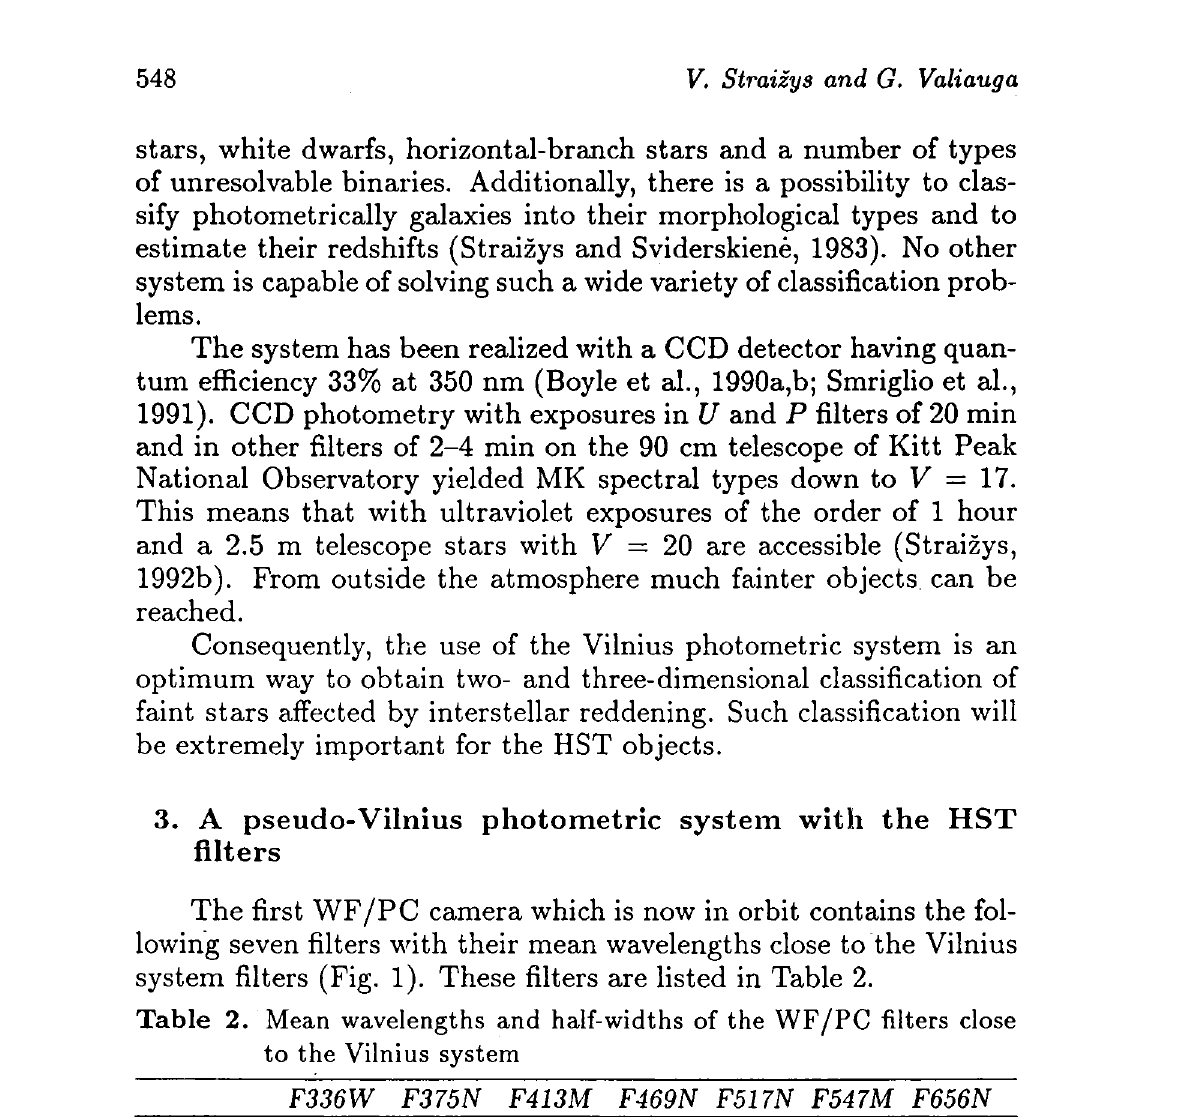
Table 2. Mean wavelengths and half-widths of the WF/PC filters close to the Vilnius